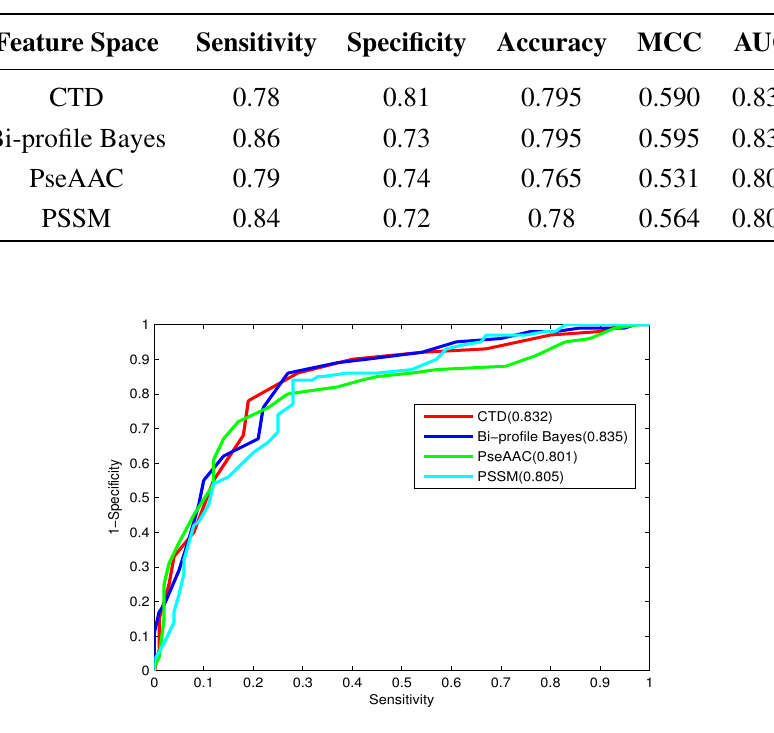
Figure 3. ROC curves of the best-performing individual feature